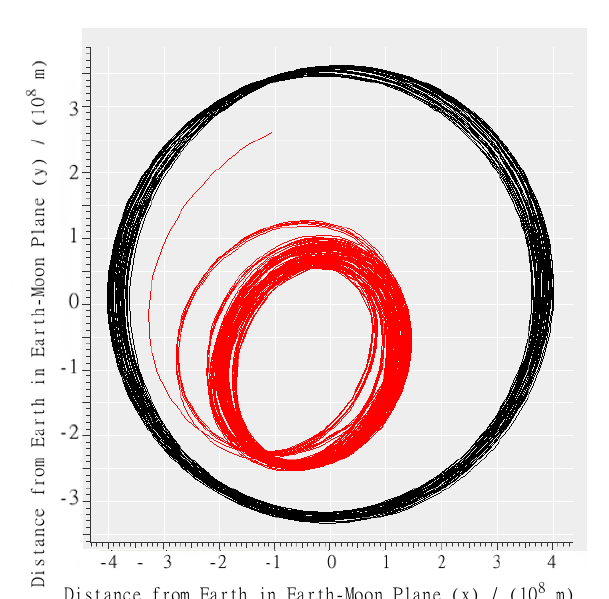
Figure 12. A characteristic trajectory in earth-inertial for a state taken from the lower right corner of the stability plot. The axes represent positions in the earth-centered reference frame. The black line (outer loop, circular trajectory) represents the moon’s trajectory. The red line (inner loop) represents the vehicle trajectory. This is not representative of a DRO and its stability is highly questionable. There is potential for this type of orbit to be useful with the availability of some control